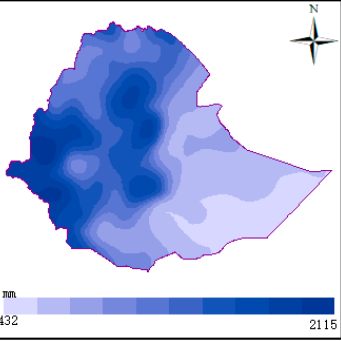
Figure 4. High-resolution map of the mean annual precipitation in Ethiopia during 1990–2020 generated using our hybrid of MLPs.